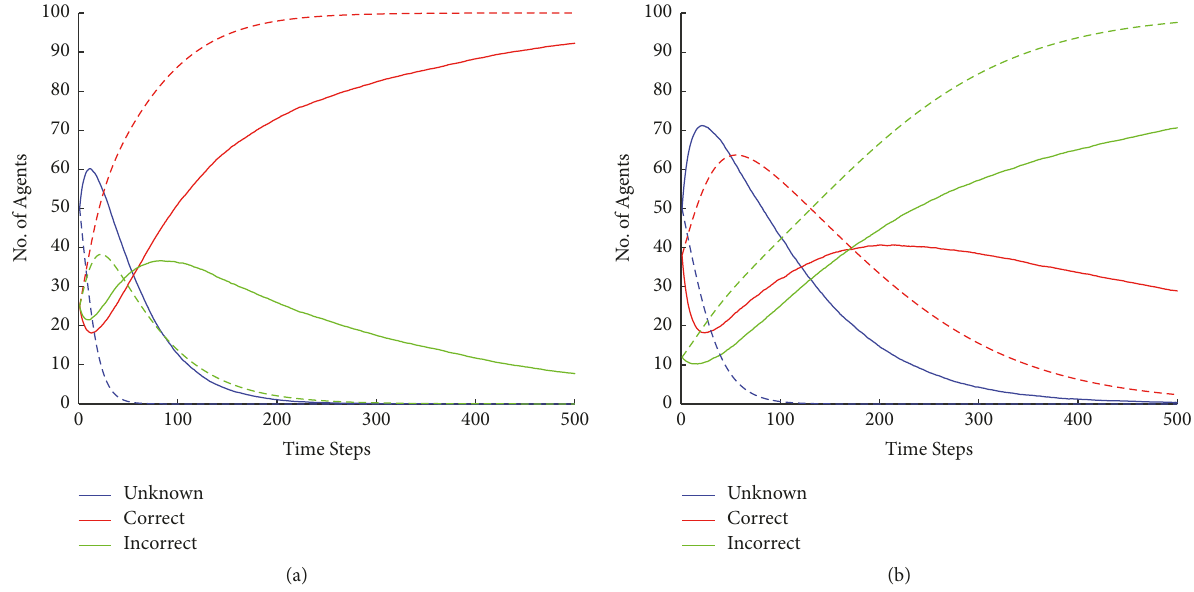
Figure 8: Results against both scenarios against similar configuration of trust. (a) LHH case against “nominal scenario”; (b) LHH case against “wishful-thinking